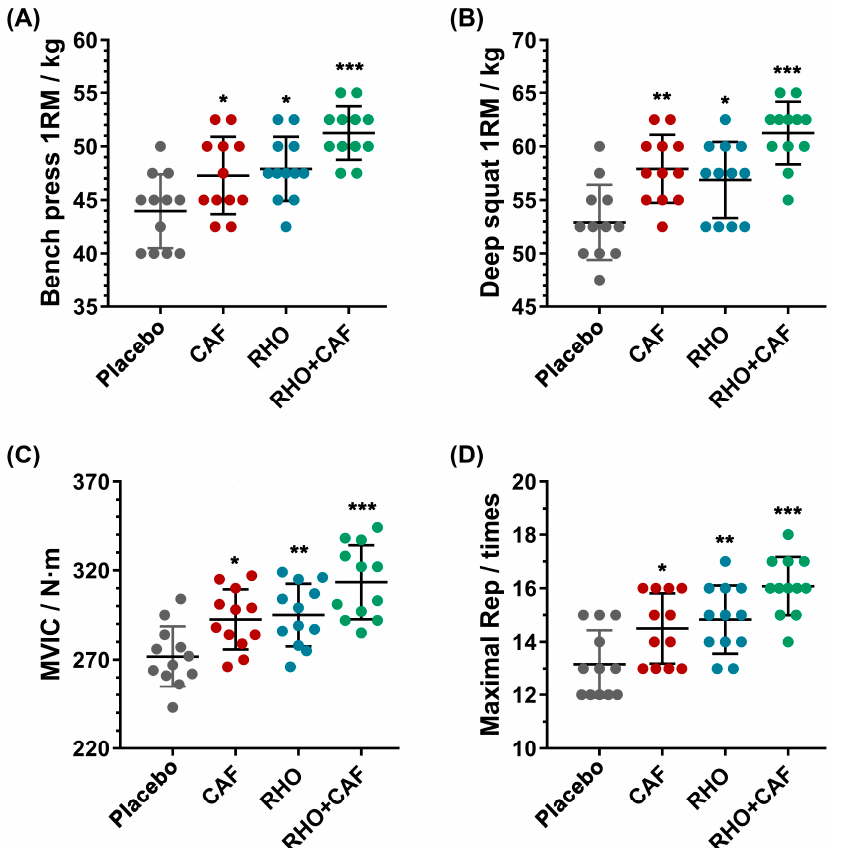
Figure 4. Changes for participants without resistance training experience after receiving supplements. ( A ) Bench press 1RM. ( B ) Deep squat 1RM. ( C ) MVIC. ( D ) Maximal repetitions of 60% 1RM bench press. All data are presented as mean ± SD (n = 12 × 4 groups = 48 samples). * indicates p < 0.05, ** indicates p < 0.01 and *** indicates p < 0.001 compared with placebo group.